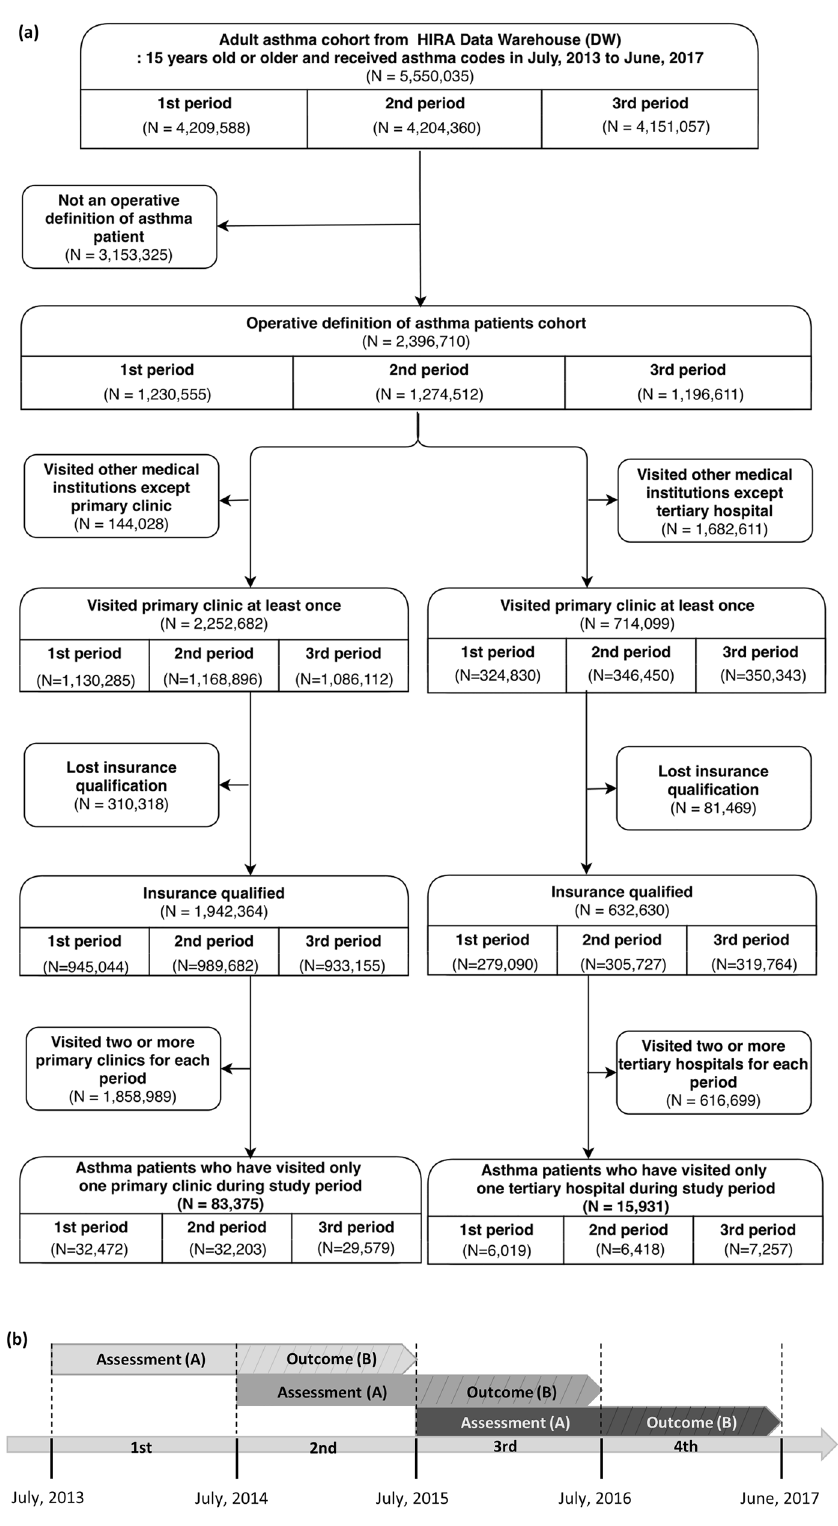
Figure 1. ( a ) Selection process of the study cohort. The study population was categorized as 83,375 primary clinic patients and 15,931 tertiary hospital patients, after all of the following exclusion criteria. ( b ) Retrospective study design. Assessment outcome and other explanatory variables were collected during the premeasurement period (A), and the exacerbation as outcome of assessment was collected the following measurement period (B) for three assessment periods,